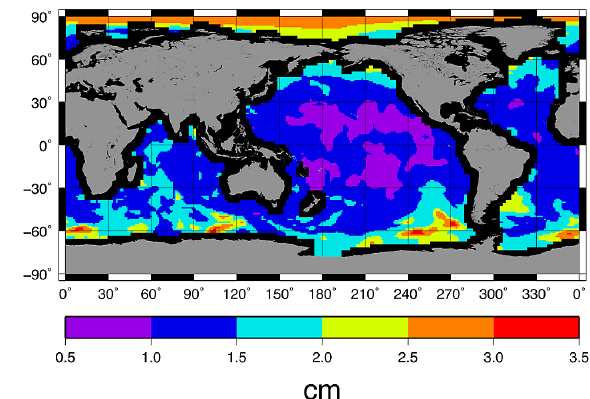
Fig. 8. Standard deviation of differences between unsmoothed OBP from RL05 AOD model and CSR RL05 mapped OBP that has been destriped and smoothed with a 500km